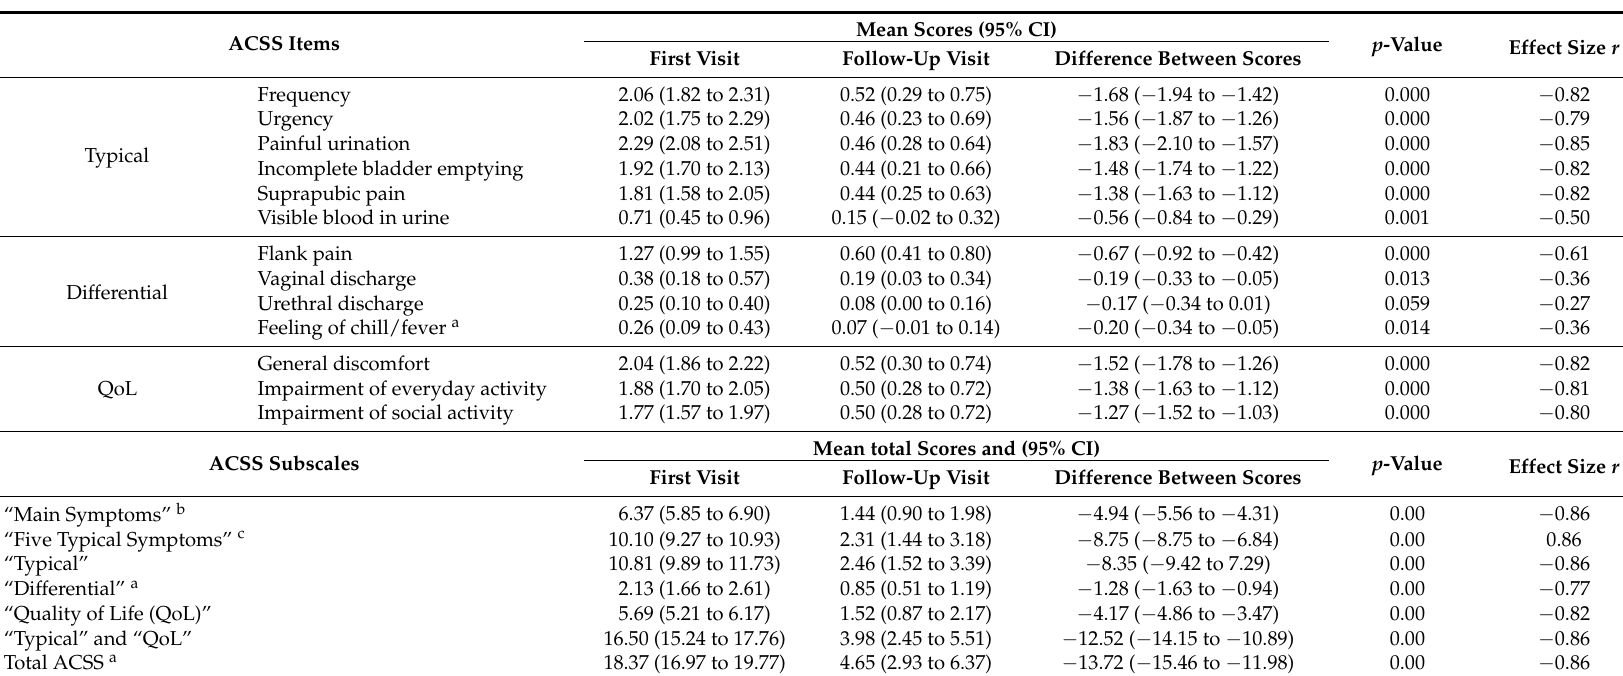
Table 3. Mean scores and 95% confidence intervals (CI), effect sizes correlation coefficient (r) of ACSS items, and subscales in 48 female patients at first and follow-up